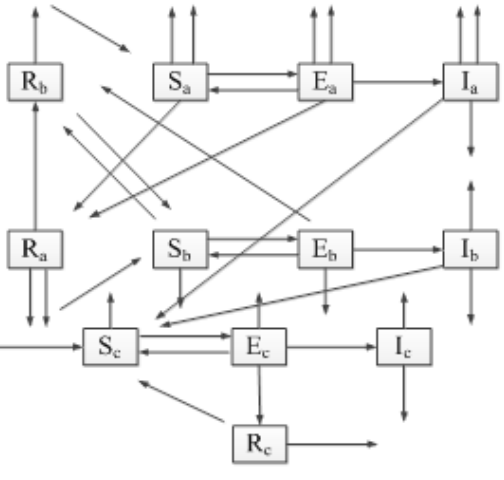
Figure 1. Rabies transmission